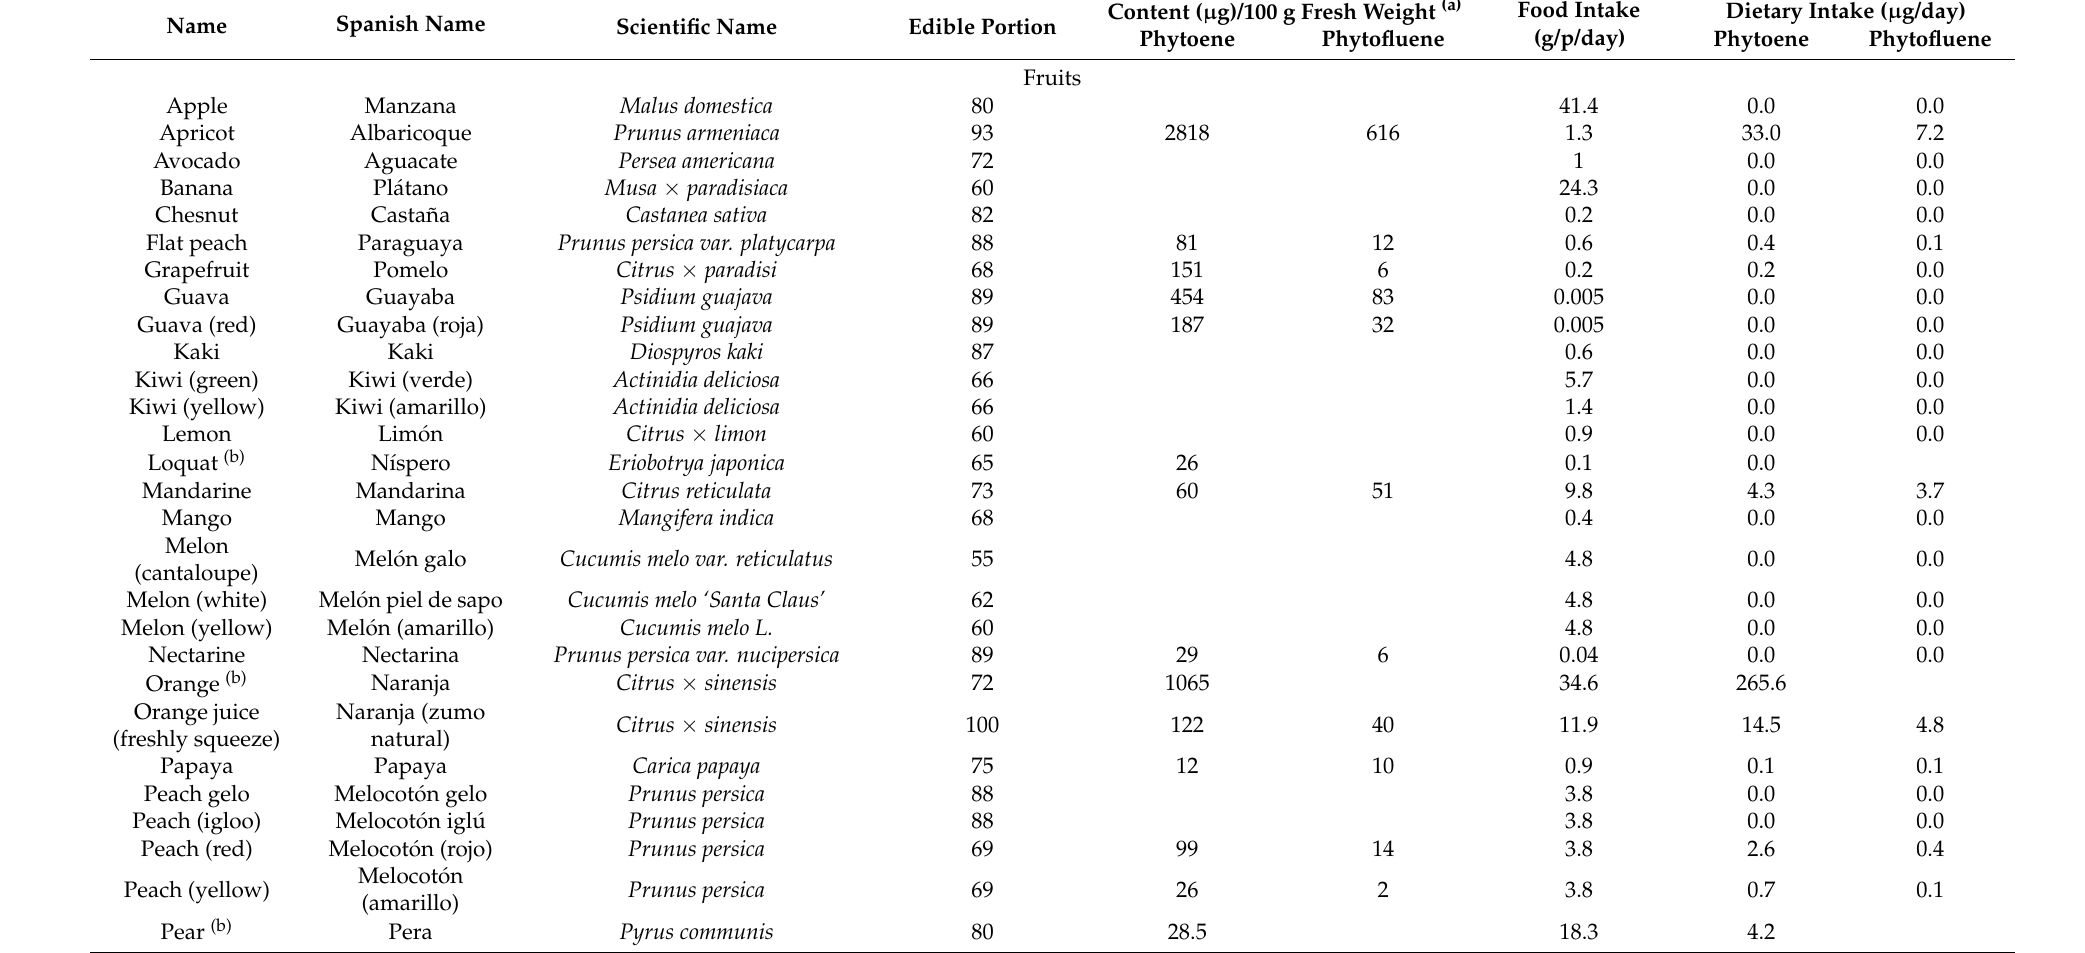
Table 1. Phytoene and phytofluene content ( µ g/100 g fresh weight) (a) of fruits, vegetables and processed foods and daily intake ( µ g/person) and the consumption of fruits, vegetables, sauces and orange and tomato juices among the adult Spanish